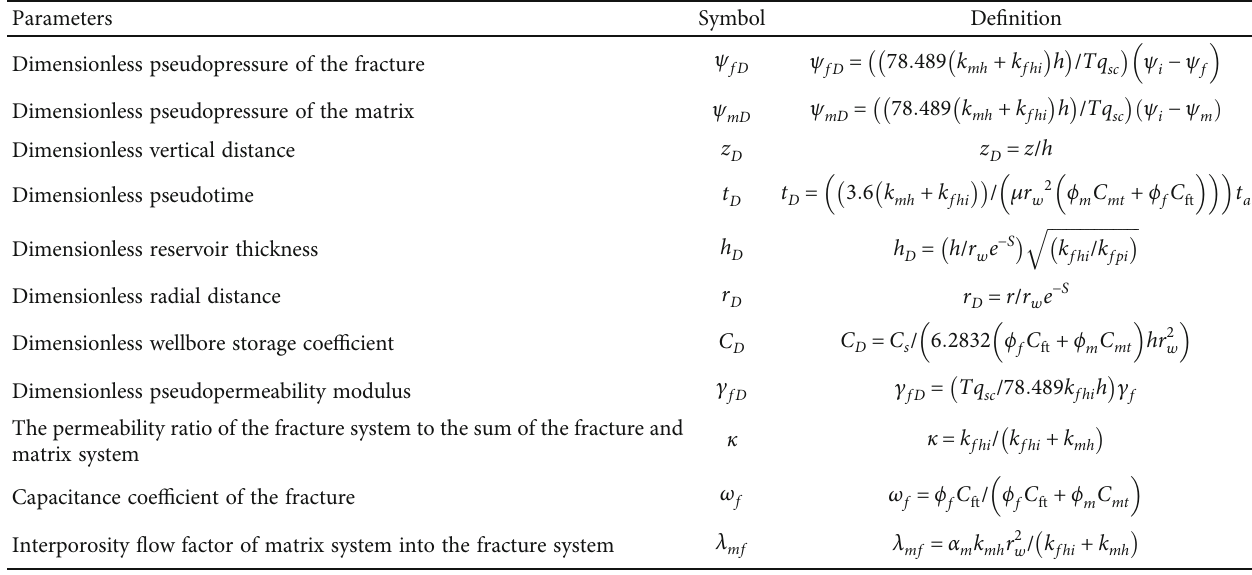
Table 1: De fi nitions of the parameters used in this